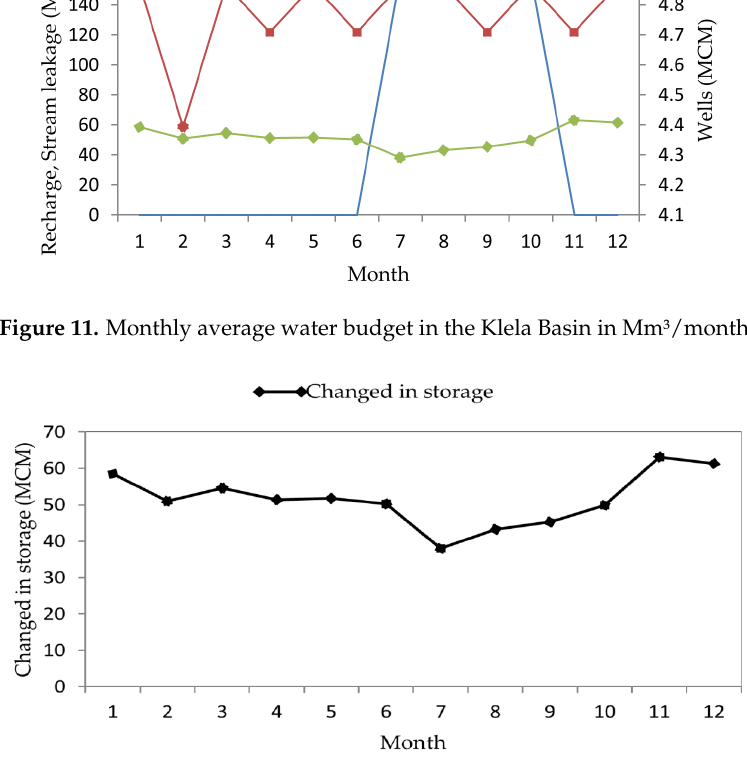
Figure 12. Monthly change in groundwater storage (Mm 3 /month) in the Klela Basin.